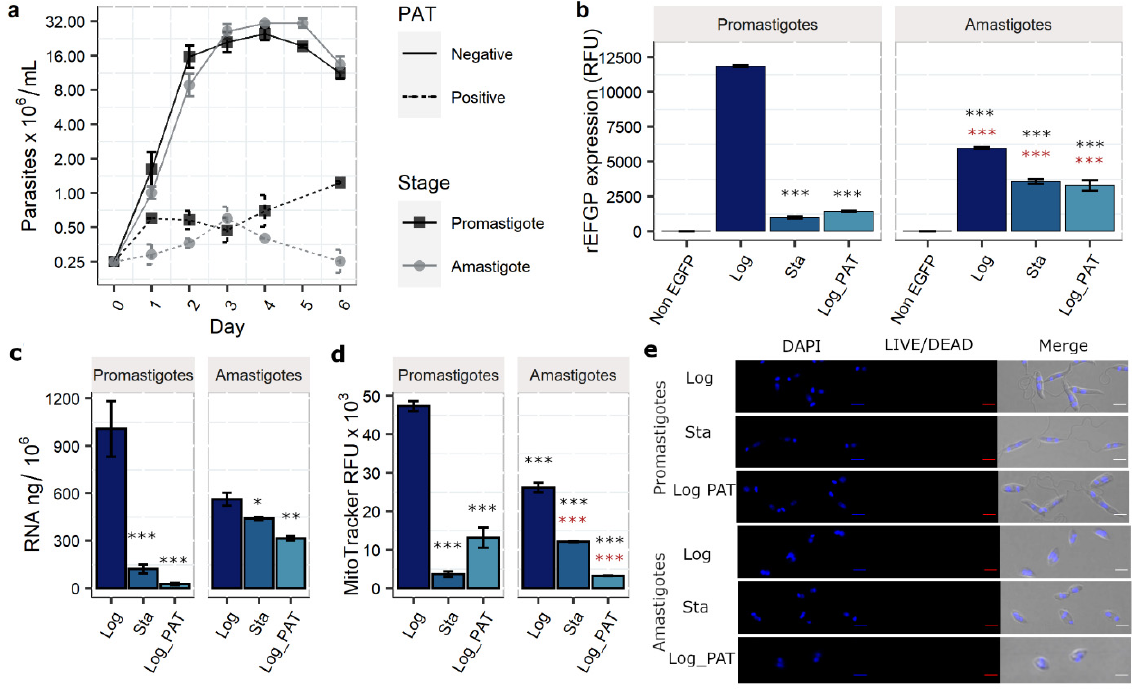
Figure 1. Evaluation of stationary phase and drug pressure as models of quiescence. Four parame- ters with associated downregulation in quiescent cells in addition to cell viability were evaluated. ( a ) Assessment of proliferation as indicated by growth curve of promastigotes and amastigotes in absence (solid lines) and presence (dashed lines) of Potassium Antimonyl tartrate (PAT). ( b ) rEGFP expression in proliferative (Log) and non-proliferative (Sta, Log_PAT) conditions. ( c ) Quantification of the total RNA content per million cells. ( d ) Quantification of the mitochondrial membrane poten- tial as indicated by the fluorescence of Mitotracker. In figures ( b – d ), the results represent the mean ± SEM of three biological replicates. The asterisks represent statistically significant differences after Tukey’s post-hoc test; * p < 0.05, ** p < 0.01, *** p < 0.001. The asterisks in black and red represent statistically significant differences compared with promastigotes and amastigotes in Log, respec- tively. ( e ) Confocal images of Leishmania cells under the evaluated conditions (after enrichment of viable cells for condition Sta and Log_PAT). The pictures show their morphology, size, and cell viability, as indicated by their membrane integrity and absence of cytoplasmatic staining with the non-permeable dye LIVE/DEAD™ Fixable Red Stain. The maintenance of their nuclear and kineto- plast DNA is shown with DAPI staining. The sale bar represents 5 μ M.